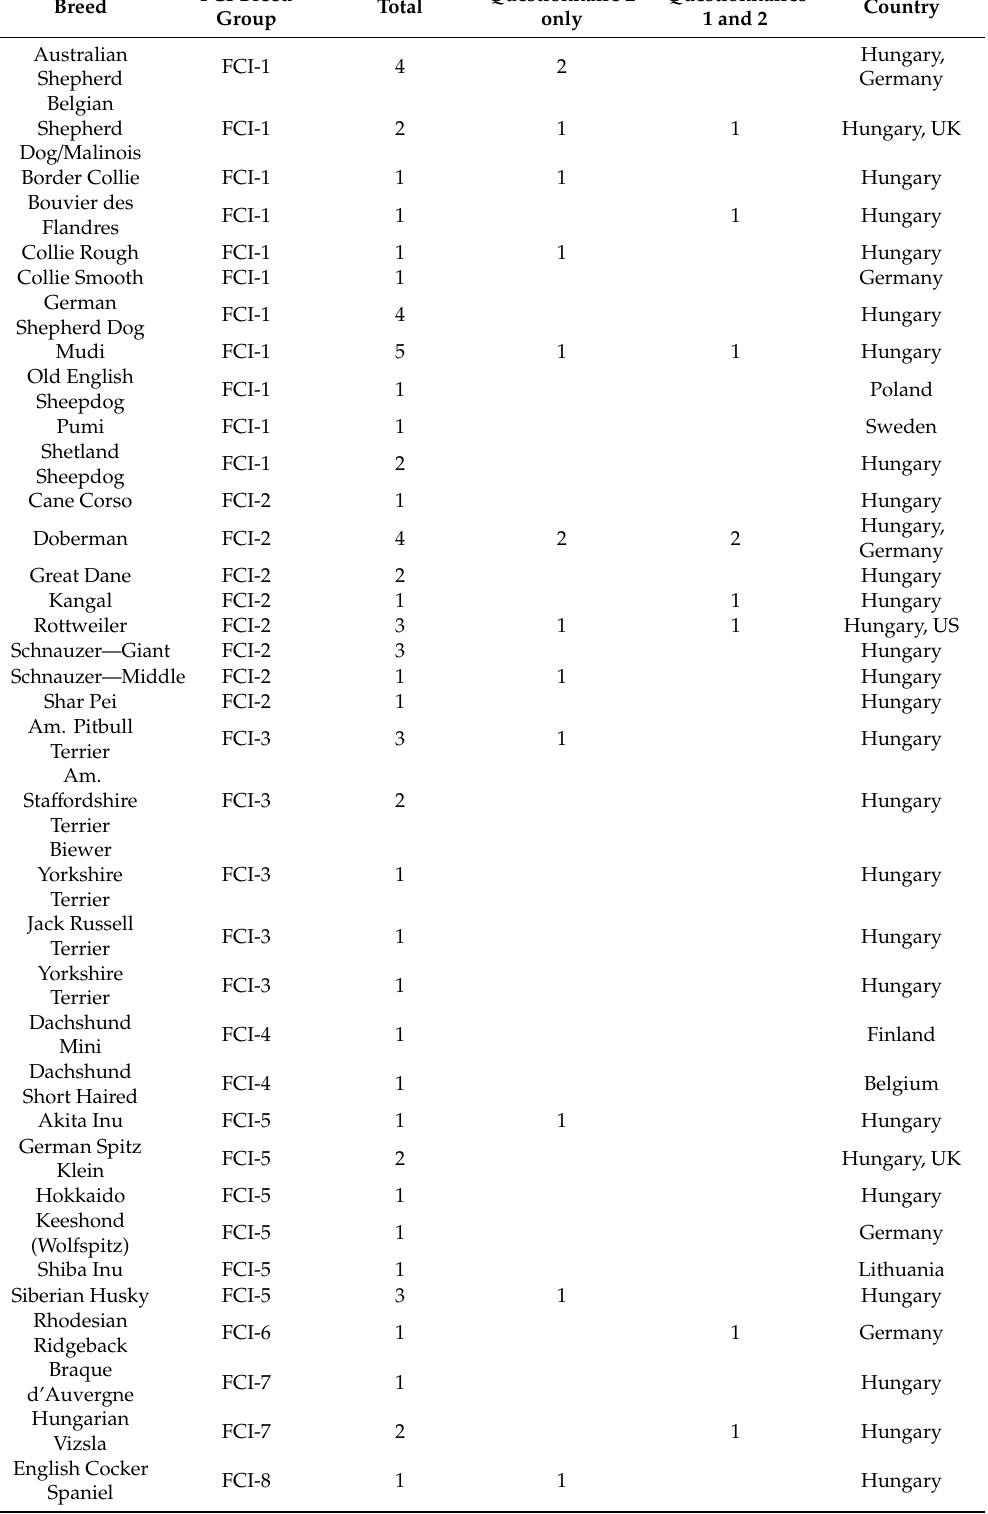
Table 1. Distribution of breeders according to countries and participation in the questionnaire surveys. In the column marked with “Total”, the numbers represent the sum of individual respondents (of